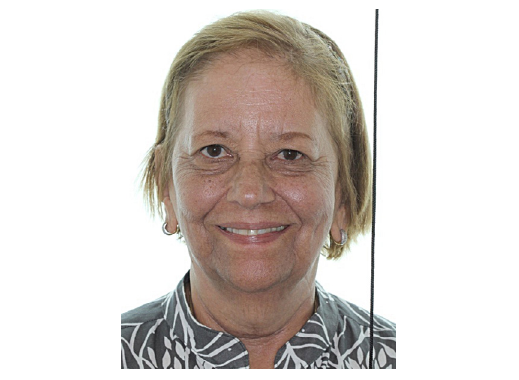
Figure 5. Examples of data collected. Group 4 (age